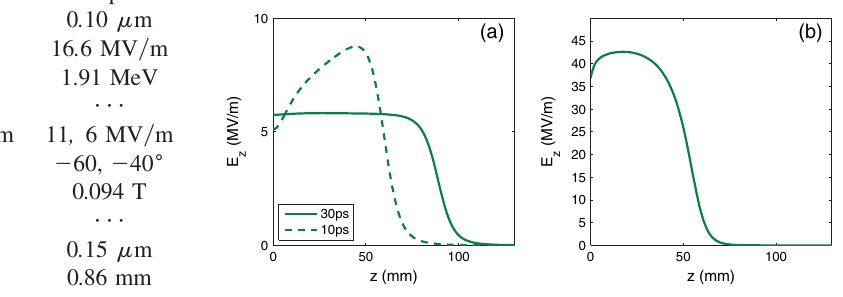
FIG. 8. Field profiles for optimized geometries: (a) dc and (b) SRF